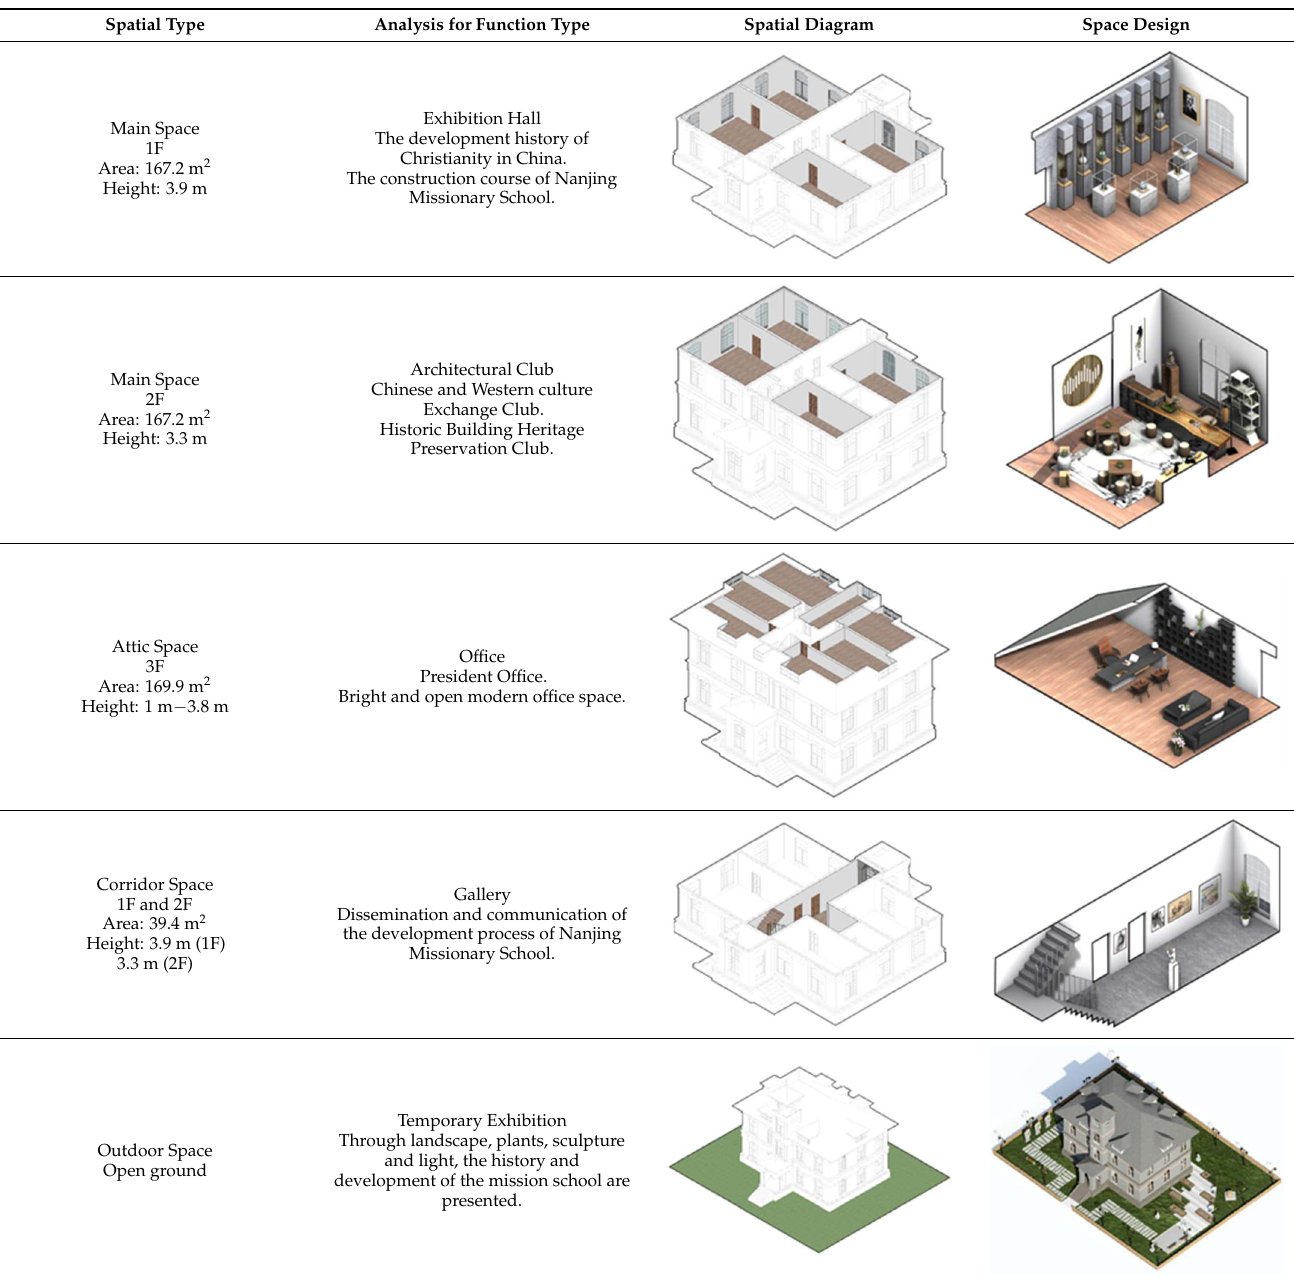
Table 1. Adaptive reuse analysis of the bell tower (source: author).